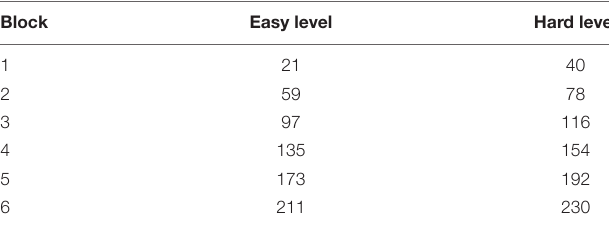
TABLE 1 | The scan number when each stimulus block is